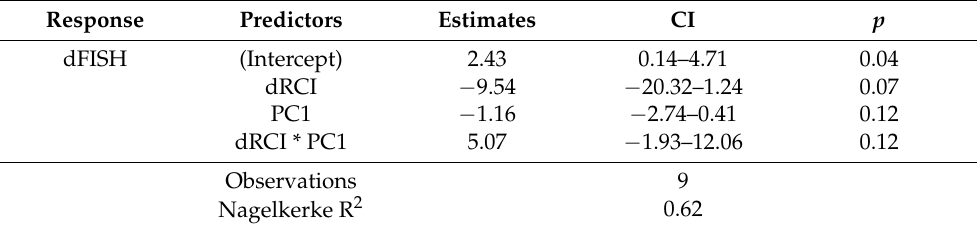
Figure 4. Context dependent fish responses to forest buffers in the Oslo Fjord basin. Increasing urbanization (PC1) weakened the potential for riparian buffer (dRCI) to have a positive effect on fish densities (dFISH). PC1 explains 56% variation in catchment-wide human impacts. Each point represents a site pair (unbuffered and buffered sites) in the Oslo Fjord basin. Table 1. Results from the General Linear Models (GLM) testing the influence of riparian condition (RCI), upstream human activities (i.e., upstream catchment degradation “urbanization”), and their interaction on fish densities. The model use log response ratios to describe the magnitude of change in the response (dFISH) and predictor (dRCI) variables between site-pairs (i.e., unbuffered upstream sites and downstream, buffered sites) whilst controlling for the existing level of ecological impairment (i.e., upstream PC1). PC1 is the Axis 1 sites scores from a Principal Components Analysis (PCA) explaining 56% variation in catchment-wide human impacts. CI, 95% confidence